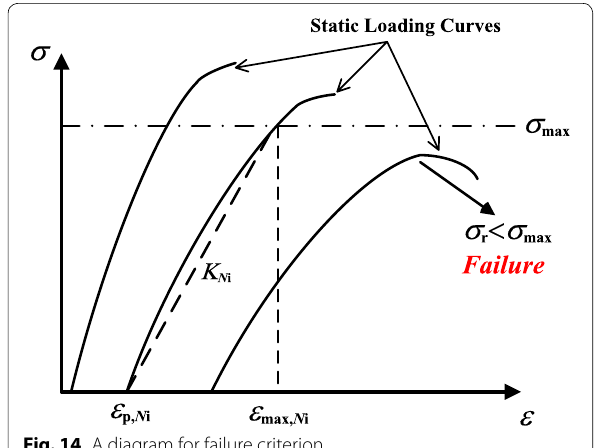
Fig. 14 A diagram for failure